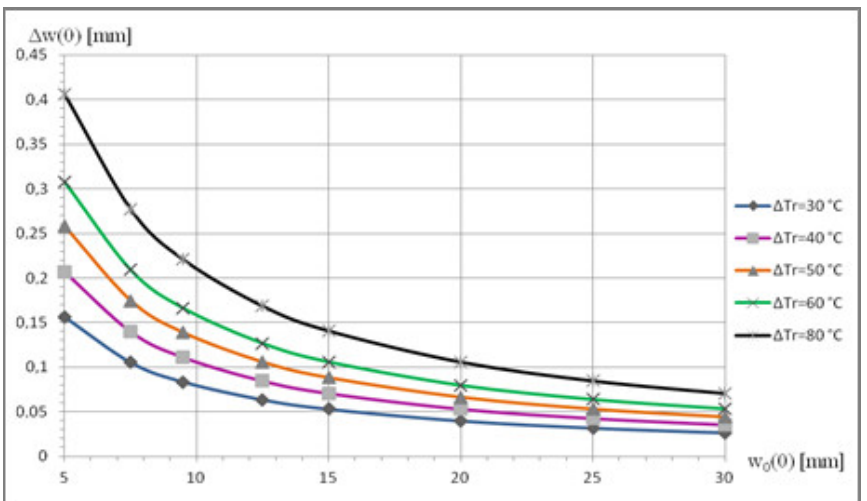
Figure 13. Additional deflection (∆w(0)) for the SE made of titanium alloy with 160 mm diameter as a function of its initially designed deflection (w 0 (0)).